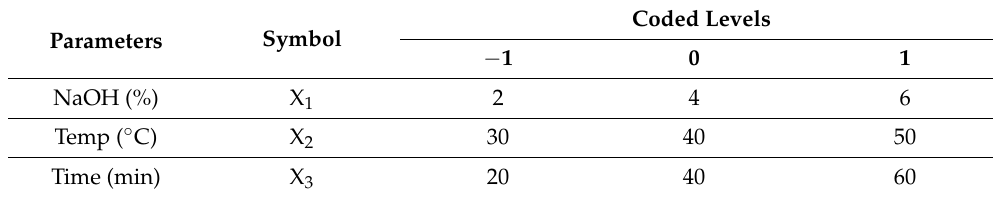
Table 1. Coding of experimental parameters and related